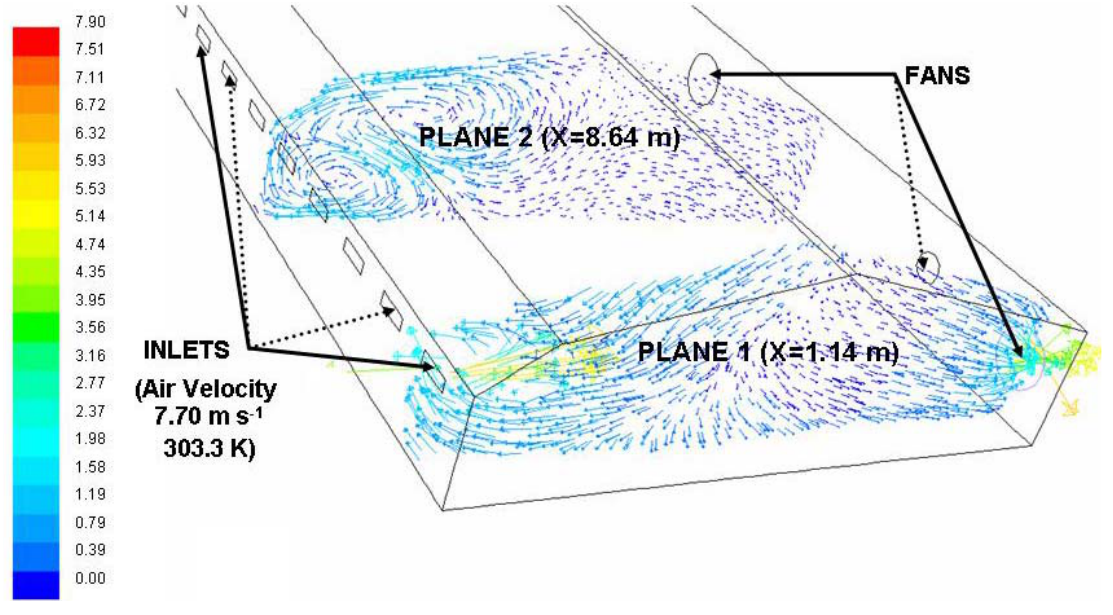
Figure 4. Vectors of air velocity showing trajectories in Planes 1 and 2 of the Figure 3. Air velocity is expressed in m s − 1